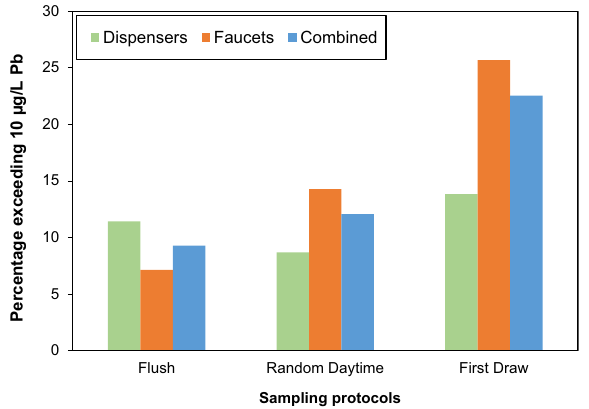
Fig. 4 Pb contamination in water samples using different sampling protocols. Percentage of samples exceeding 10 μ g/L Pb from dispensers and faucets using fl ush, random daytime and fi rst draw sampling protocols. Combined represents both dispenser and faucet samples considered collectively.